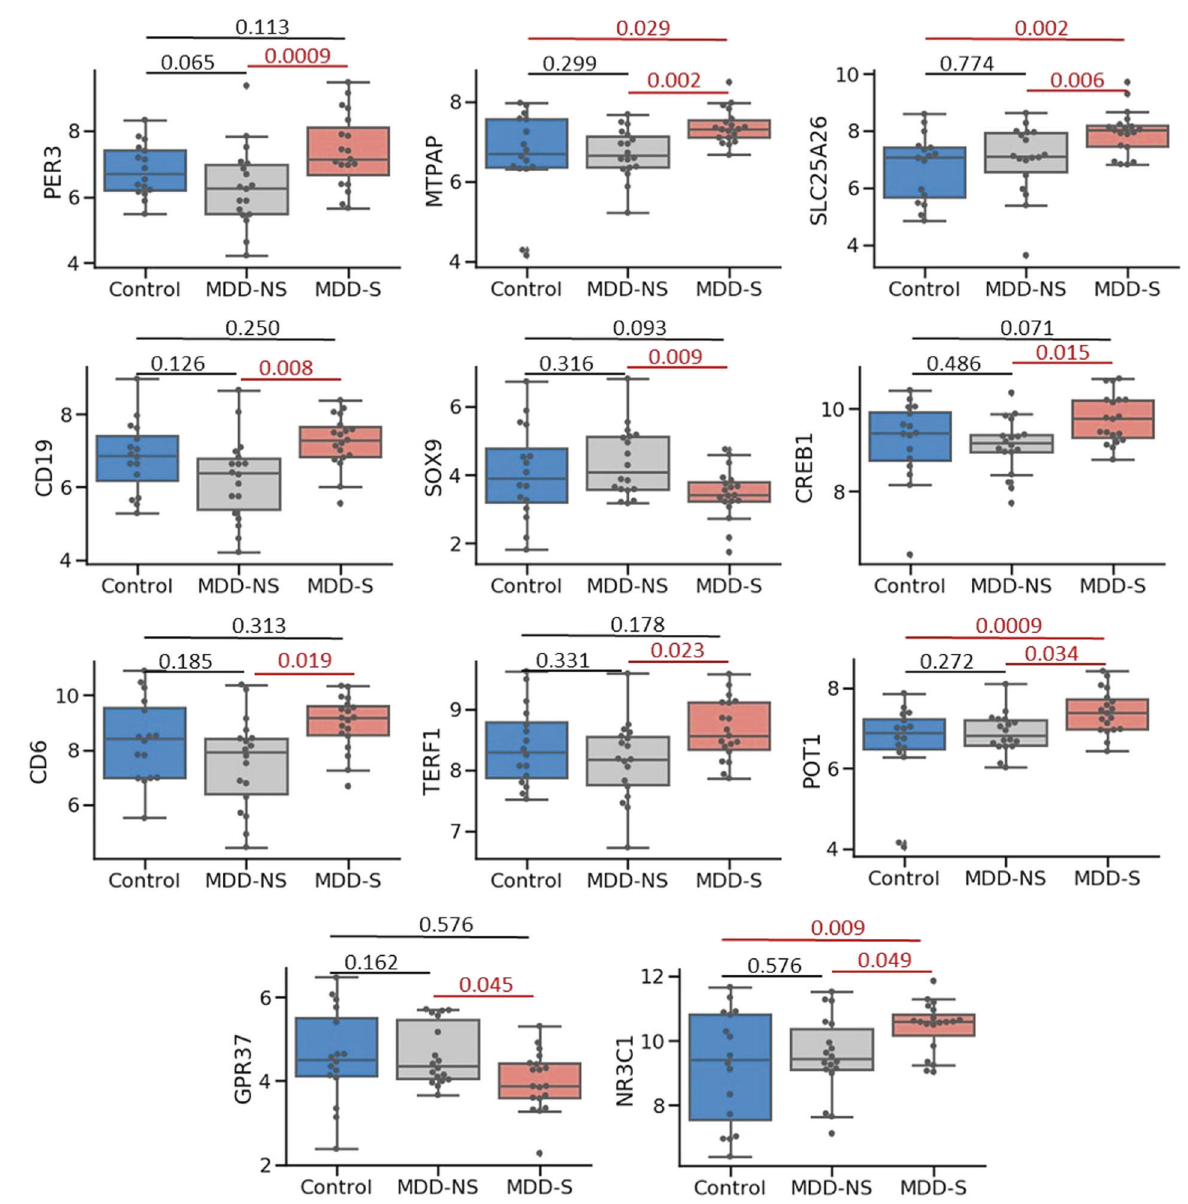
Fig. 1 Genes differentially expressed in blood. Graphical representation of eleven genes signi fi cantly differentially expressed between MDD-S and MDD-NS in blood, at p -value ≤ 0.05, and also passing FDR correction for multiple testing at q ≤ 0.1. Four of the 11 genes; MTPAP (Mitochondrial Poly(A) Polymerase), SLC25A26 (Solute Carrier Family 25 Member 26), NR3C1 (Nuclear Receptor Subfamily 3 Group C Member 1), and POT1 (Protection of Telomeres 1) were also signi fi cantly differentially expressed between MDD-S and control